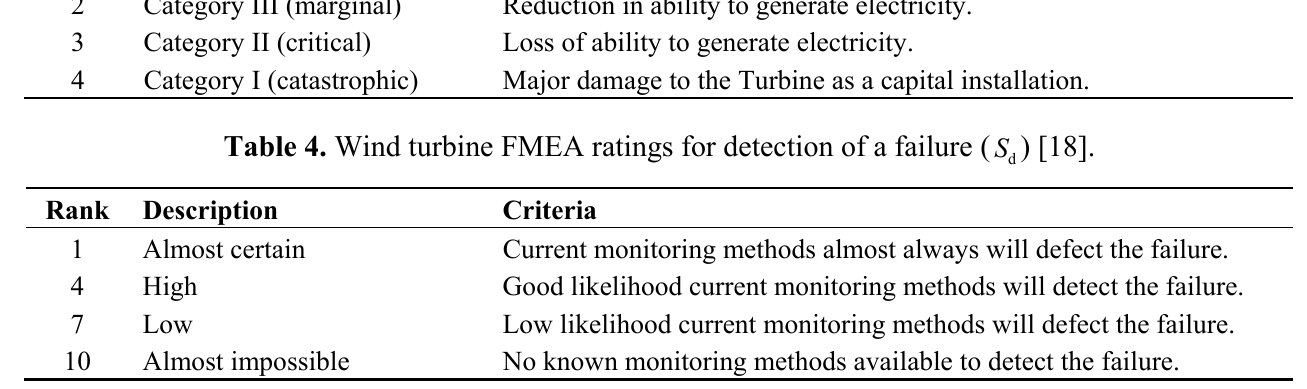
Table 3. Wind turbine FMEA ratings for severity of a failure ( S ) [18].